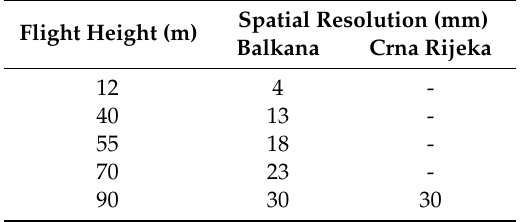
Table 1. Flight heights and spatial resolutions of the conducted surveys.